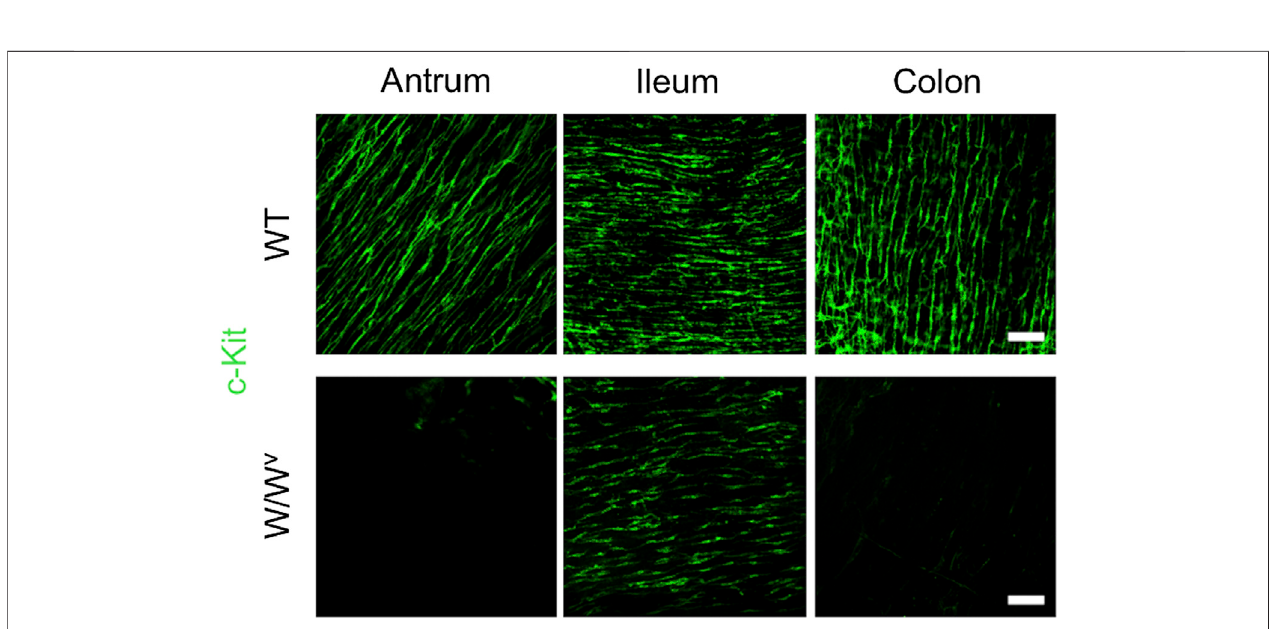
FIGURE 5 | Changes in intramuscular ICC (ICC-IM; antrum and colon) or ICC associated with the deep muscular plexus in the circular muscle layer (ICC-DMP; small intestine) in W / W v mice. These images show representative results of immunostaining for c-Kit (ICC marker; green) in whole-mount preparations of GI muscularis obtained from WT mice and W / W v mice. Images in the antrum or colon show ICC-IM. Images in the ileum show ICC-DMP. ICC-IM or ICC-DMP were observed in the tissuesofWTmiceasc-Kitpositivecells(green)intheantrum,ileumandcolon.Inthetissuesof W / W v mice,ICC-DMPwereobservedintheileum,andICC-IMinthe antrum and colon were absent. Scale bar, 100 μ